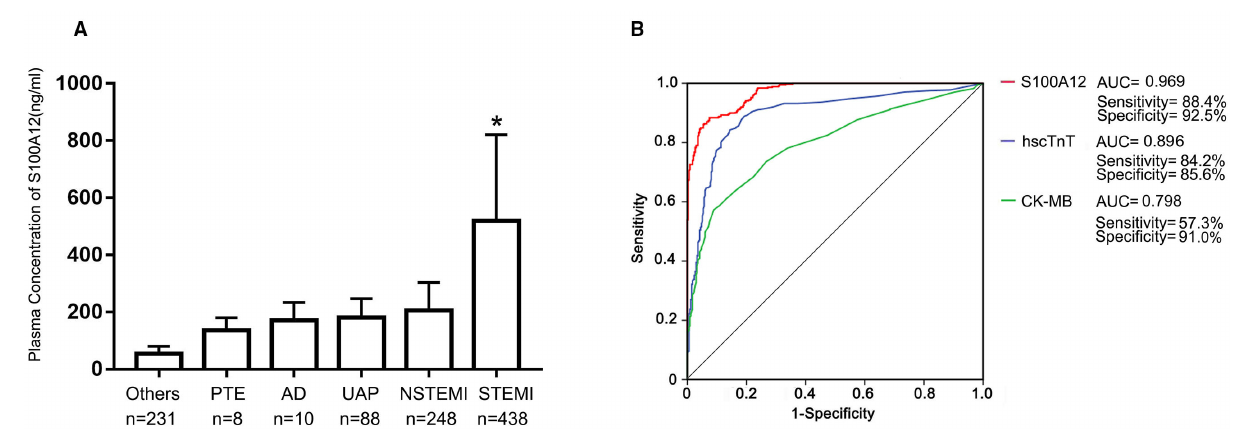
Patients in the third cohort (all of whom had STEMI) were stratified according to baseline tertile of plasma S100A12 levels ( Table 2 ). Diabetes, elevated hscTnT and symptom onset time were more common in patients with high plasma S100A12 levels; other baseline characteristics were unrelated to